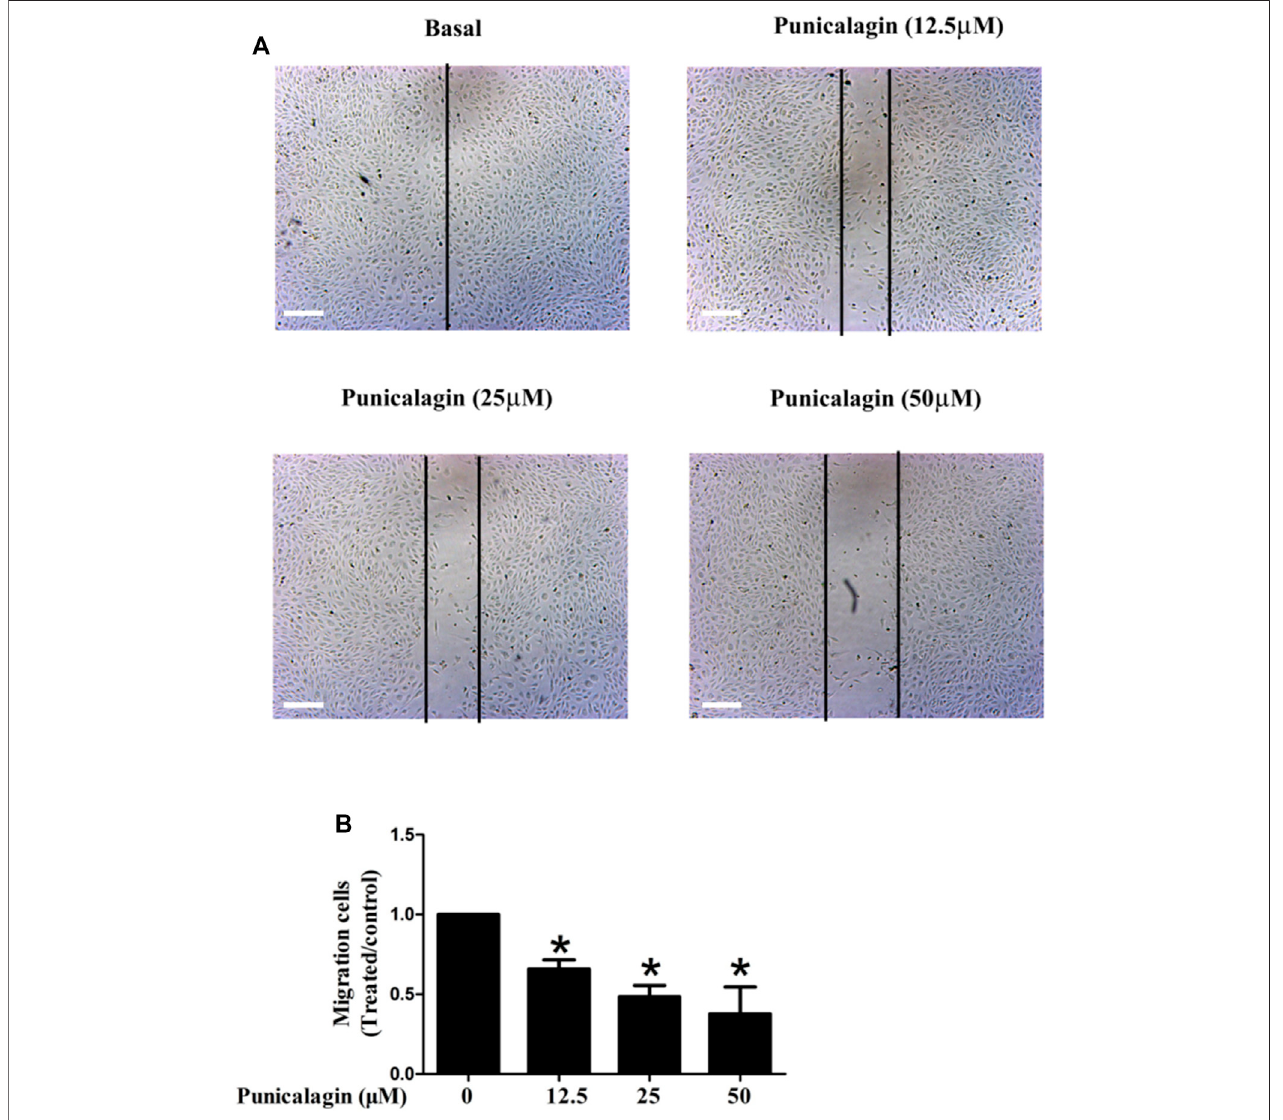
FIGURE8| EffectsofpunicalaginonHUVECs migration (A,B) .Inhibition ofpunicalaginonHUVECs migrationinwoundhealingassay(originalmagni fi cation, × 50). * p < 0.05, punicalagin treatment vs. control group.